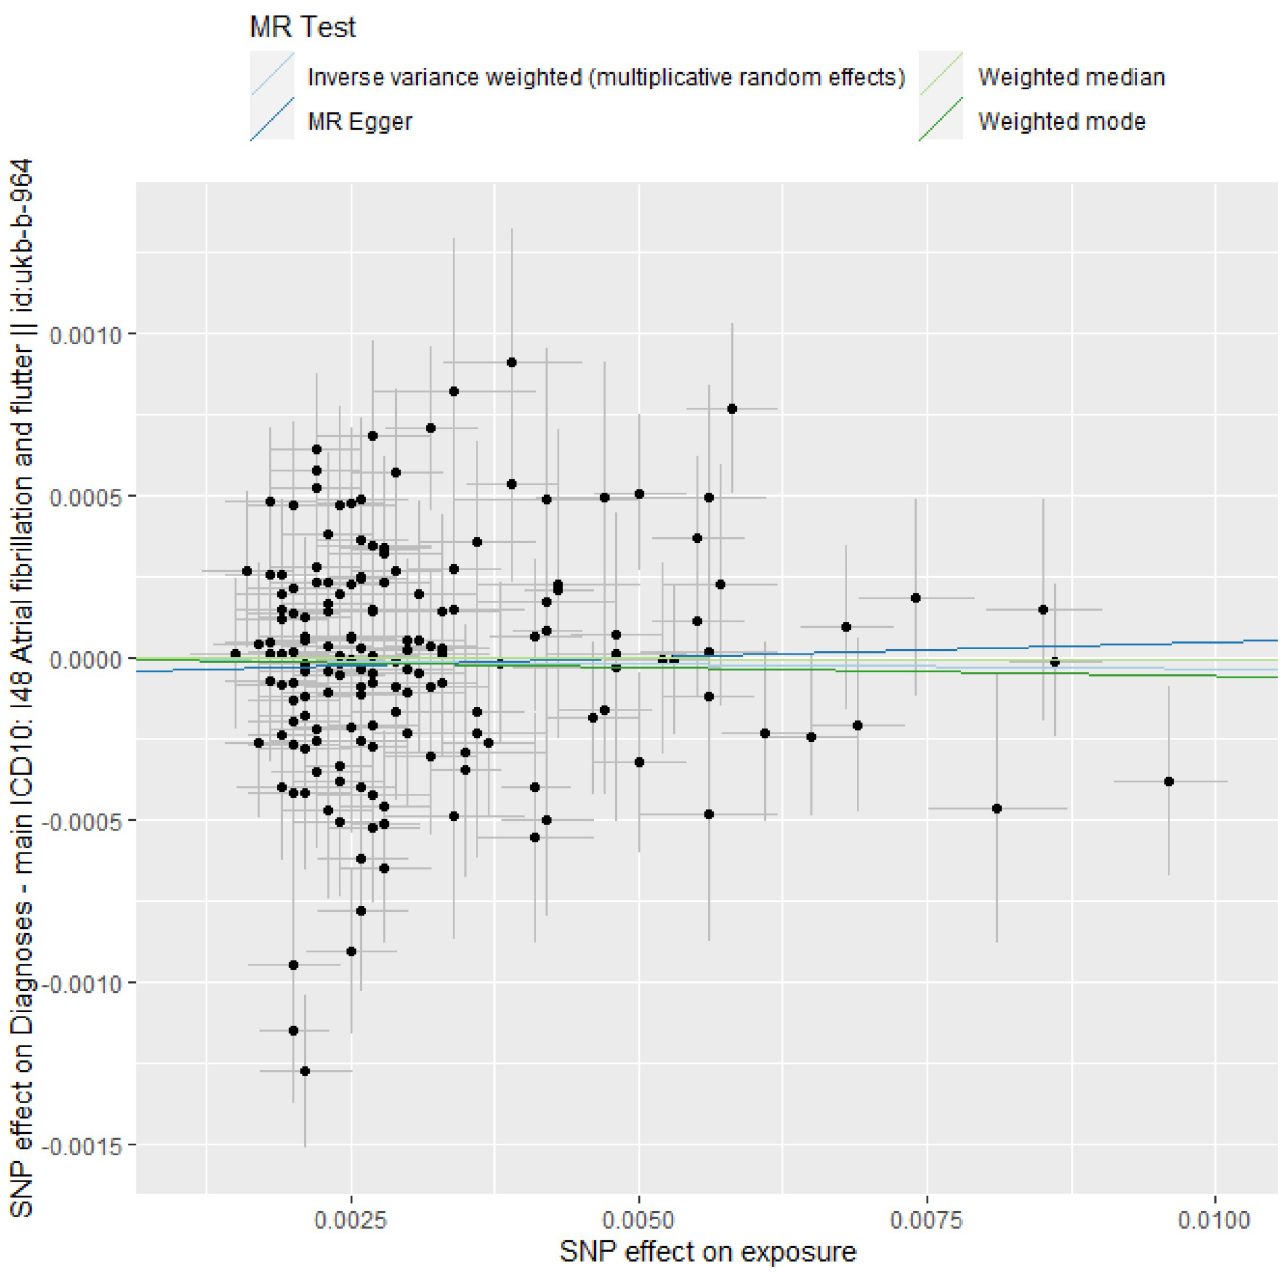
Fig 3. Scatter plot for estimating the causal effect of the change in eGFR on the risk of AF/F. https://doi.org/10.1371/journal.pone.0261020.g003 for kidney function did not exert a significant causal effect on the outcome of AF (beta, 0.105; 95% CI, -0.064–0.274; P = 0.23) [36]. The mechanisms by which AF/F may cause kidney dysfunction remain unknown. Several risk factors are shared between AF and CKD, including elevated inflammation and an acti- vated renin-angiotensin-aldosterone system (RAAS) [35]. Kidney dysfunction can occur when AF/F causes systemic inflammation and RAAS activation, but the reverse may also be true. As a possible mechanism, a decrease in cardiac output due to AF/F may cause pre-renal failure